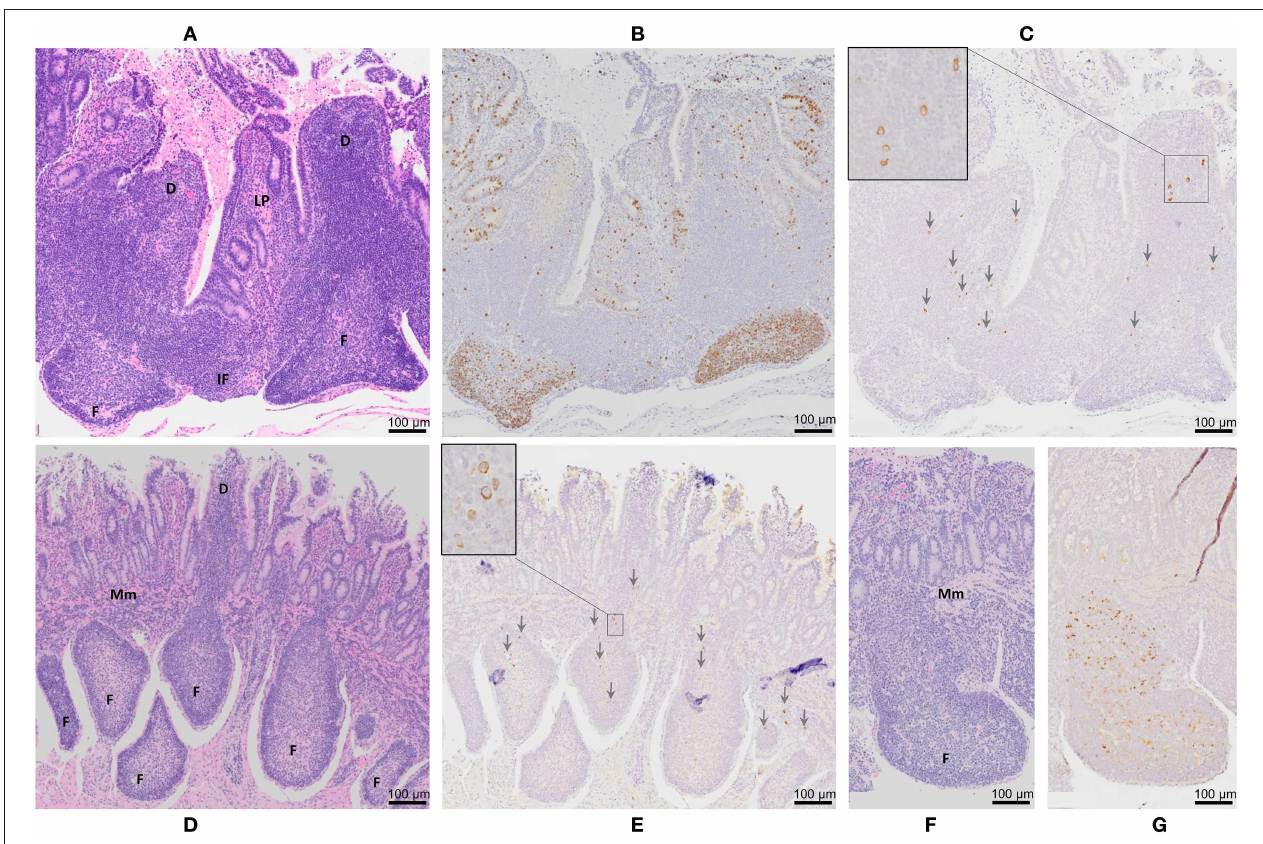
FIGURE 3 | Peyer’s patch architecture and histochemical staining of intestinal segments 12 months after MAP infection. Serial sections of a DPP were stained with (A) hematoxylin and eosin, (B) Ki-67 (brown color), and (C) MAP antigen (brown color and arrowheads). Serial sections of two CPPs stained with (D,F) hematoxylin and eosin and (E,G) MAP antigen (brown color and arrowheads). D, dome region; F, lymphoid follicle; IF, interfollicular region; Mm, muscularis mucosae. Magnification is 200X. Insets in Panels (C,E) are digital magnifications of boxed areas in the (C) dome region and (E) lymphoid follicle showing staining for MAP antigen occurs predominantly within the